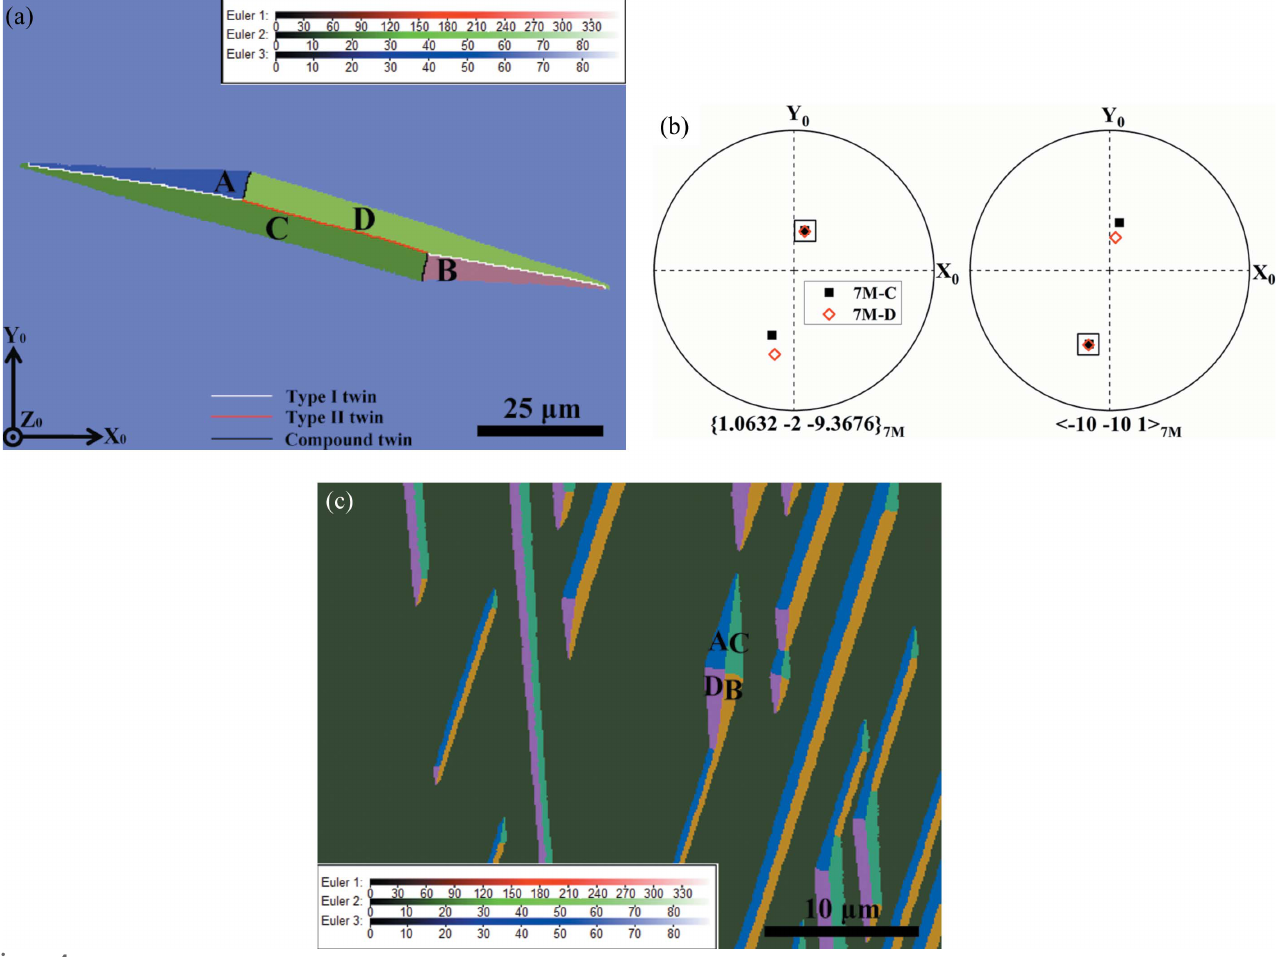
Figure 4 ( a ) An EBSD ‘all Euler’ orientation micrograph showing anisotropic elongation of diamond-shaped martensite. ( b ) Pole figures of (left) the {1.0632 (cid:5) 2 (cid:5) 9.3676} 7M twinning plane and (right) the h(cid:5) 10 (cid:5) 10 1 i 7M twinning direction for variants C and D with a type-II twin. The common poles are highlighted by squares in the figures. ( c ) An EBSD ‘all Euler’ orientation micrograph showing paired martensite plates with a spear head. The inset shows the legends of the Euler